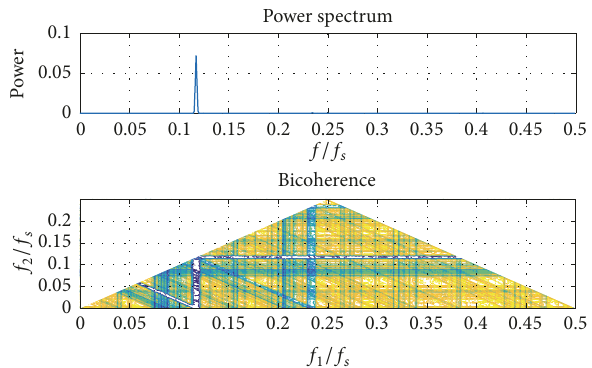
Figure 7: Contour of bicoherence of all the states of the smart grid system.